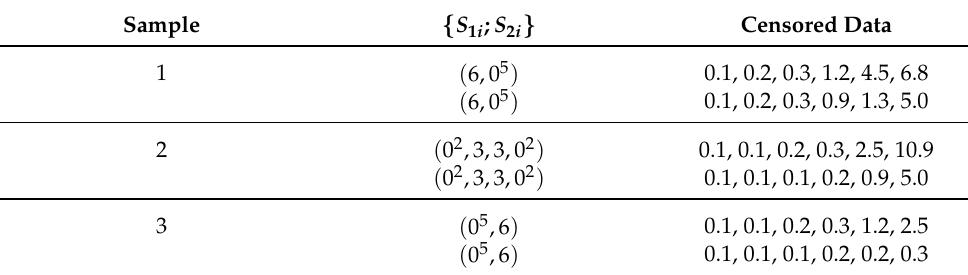
Table 3. Various PC-T-II samples from insulating fluid data. Sample